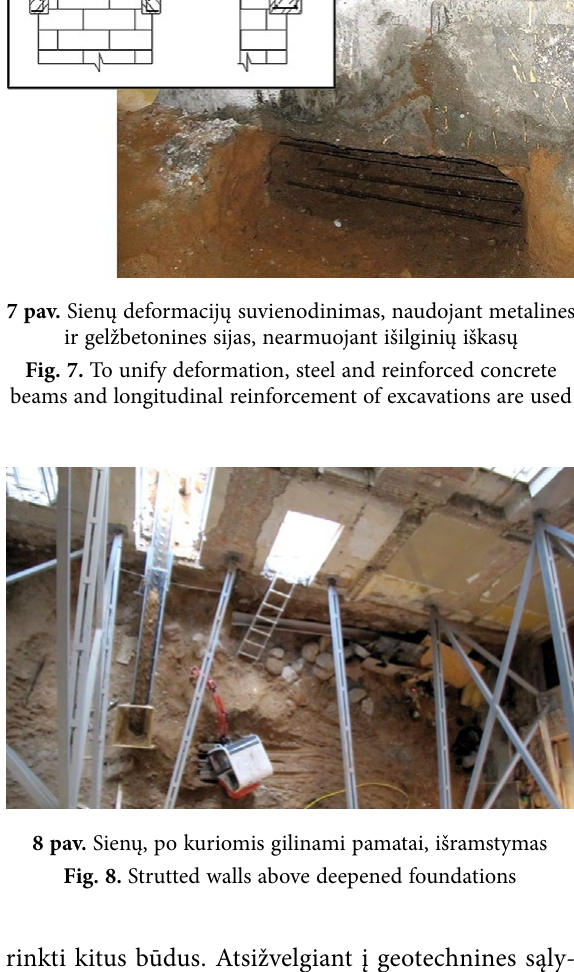
Fig. 5. The distance between excavations and their size must be determined from calculations